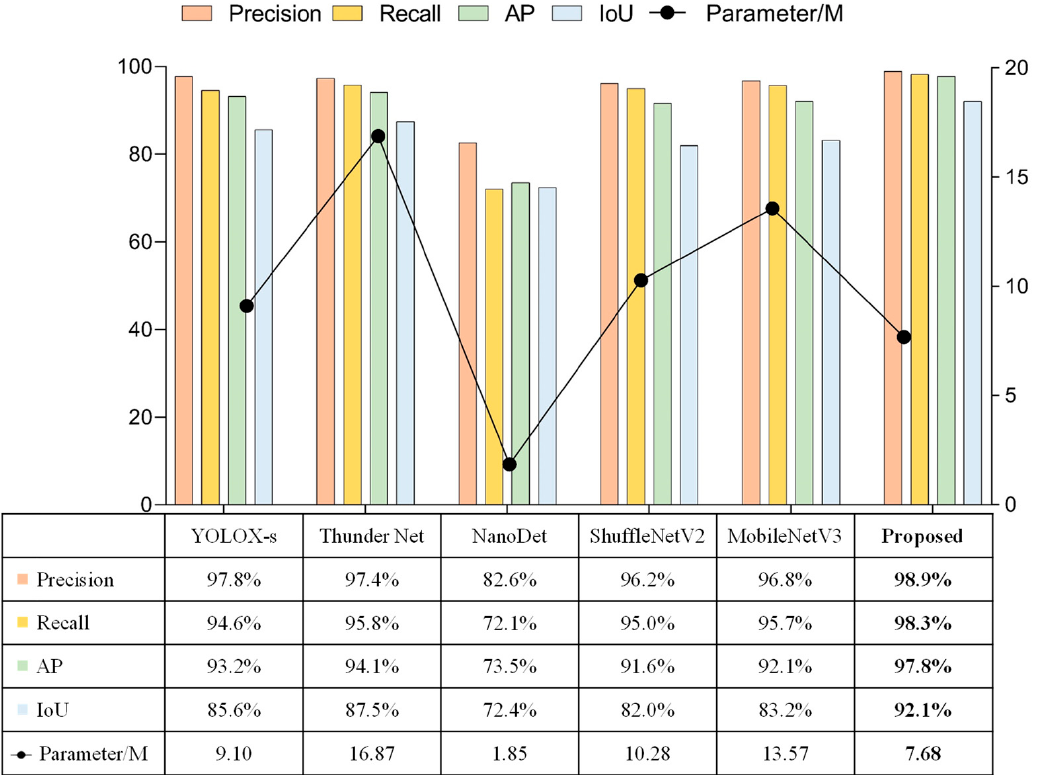
Figure 18. Experimental results of vertical table capturing.